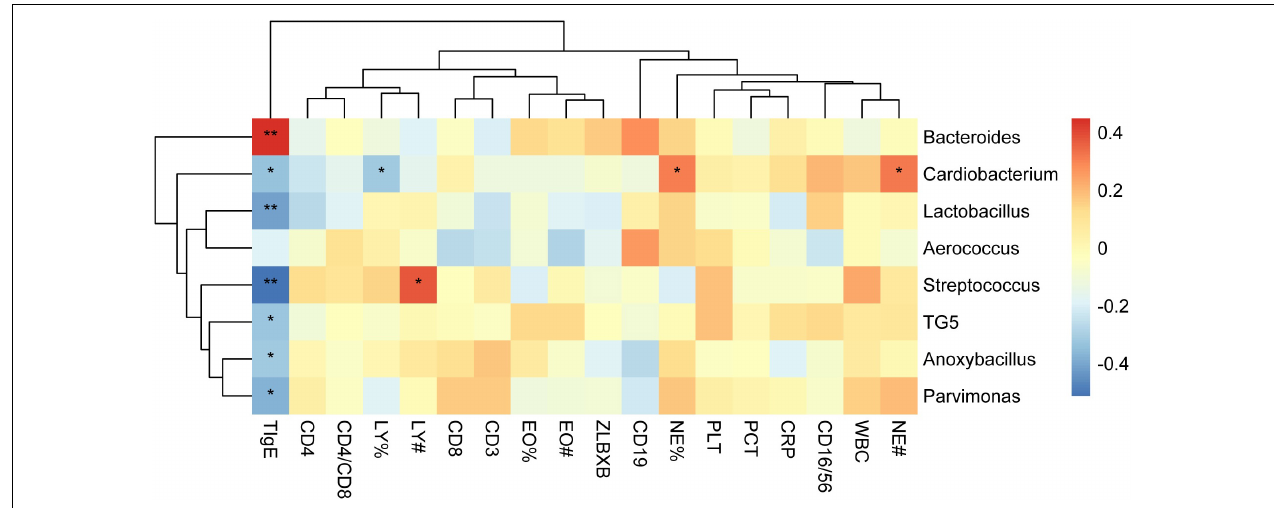
FIGURE 5 | The correlation heat map shows correlations between clinical indices and the relative abundance of genera. Correlation coefficients with the color value bar are shown in the blocks. NE%, LY%, and EO% present the percentage of neutrophile granulocyte, lymphocyte, and eosinophils count, respectively. NE#, LY#, and EO# present the absolute neutrophile granulocyte, lymphocyte, and eosinophils count, respectively. ** P < 0.01, * P < 0.05.